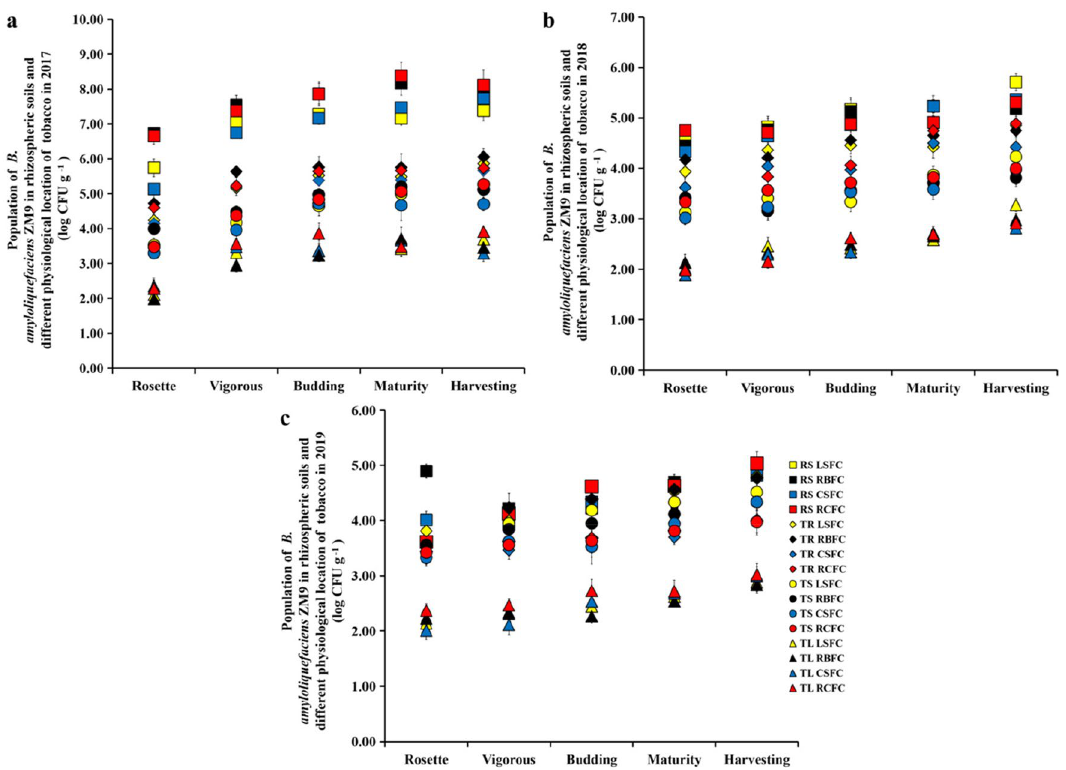
Figure 4. Population dynamic of B. amyloliquefaciens ZM9 in rhizospheric soil (RS), tobacco root (TR), stem (TS) and leaf (TL) of four treatment groups (LSFC, RBFC, CSFC and RCFC) at different tobacco growth stages in 2017 ( a ), 2018 ( b ) and 2019 ( c